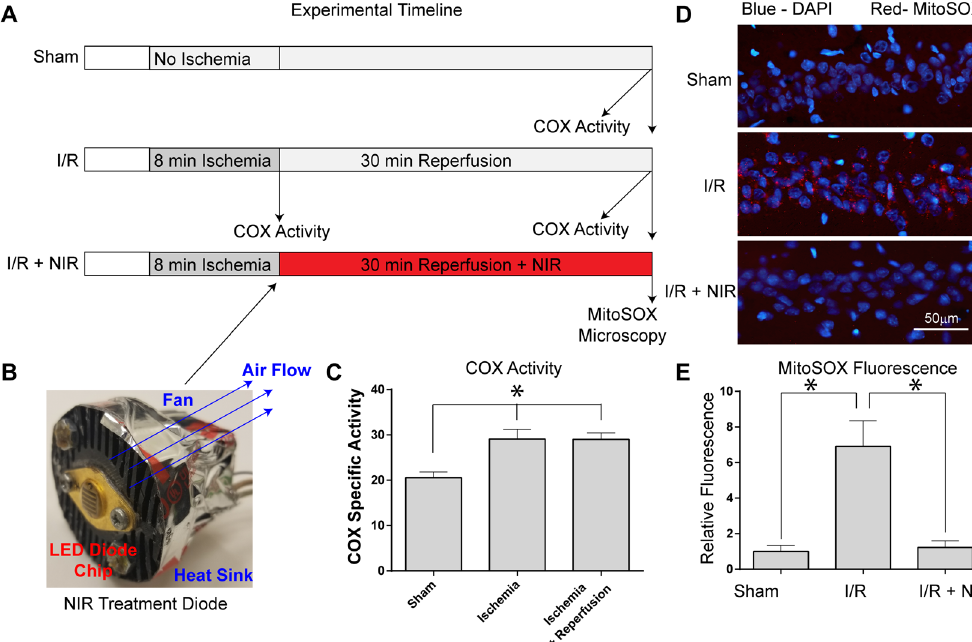
Figure 4. ( A ) Experimental timeline of COX specific activity and MitoSOX experiments. ( B ) LED array 60 chips, used for cell culture and animal studies, were mounted on heat sinks together with a small fan operated in reverse mode, eliminating unspecific heating of the diodes. ( C ) COX activity (defined as consumed O 2 ( μ mol)/ (min • total protein (mg)), analyzed in brain tissue homogenates after global brain ischemia and ischemia/ reperfusion is significantly increased compared to controls (n = 5 per group; * p < 0.05 compared to sham). ( D ) Treatment with NIR limits MitoSOX fluorescence. Nuclei were labeled with DAPI (blue) and mitochondrial ROS were detected with MitoSOX (red). [Top] sham-operated (Sham), [Middle] ischemia followed by 30 min of reperfusion (I/R), [Bottom] I/R plus NIR treatment (I/R + 950 nm). ( E ) Quantitation of red fluorescence shown in D (n = 3 per group; * p < 0.05 compared to sham operated